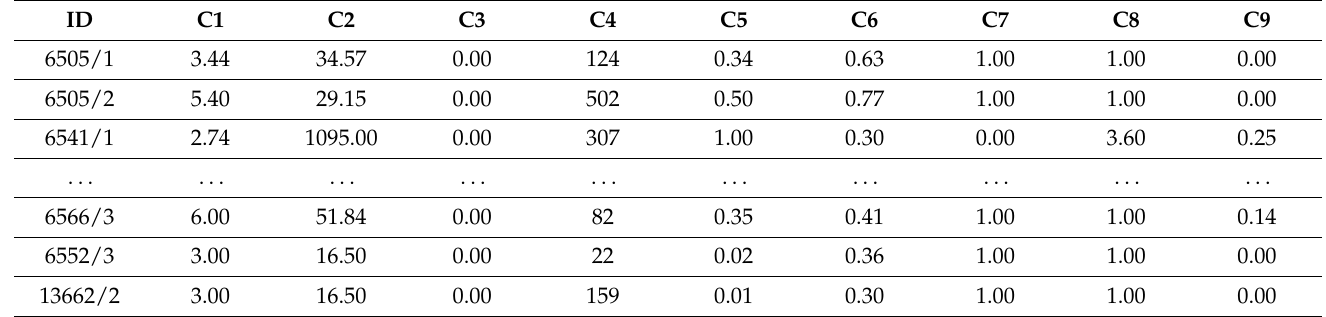
Table 7. The results of the evaluation of cadastral parcels according to defined criteria.